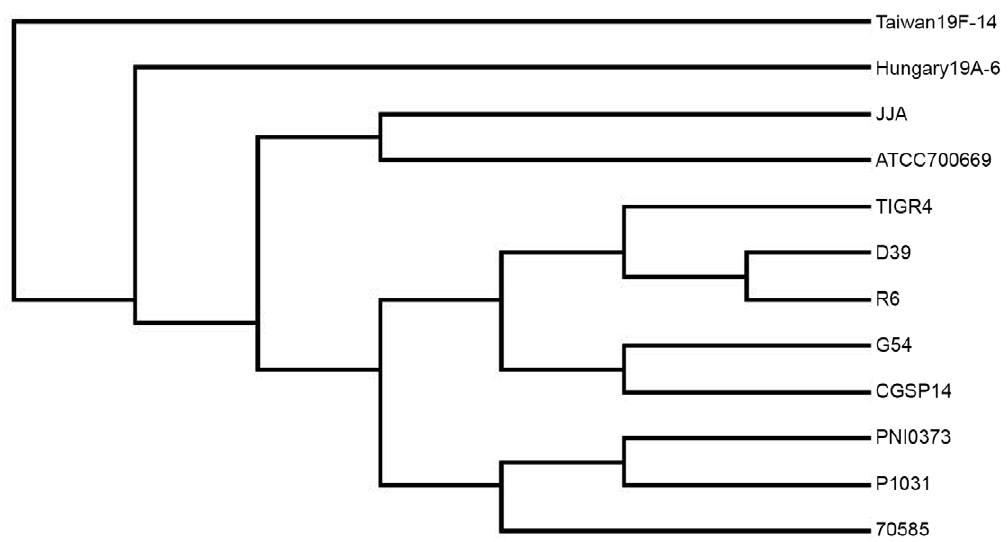
Figure 5. Gene content-based dendrogram of complete pneumococcal genomes. The presence or absence of orthologs within clusters for each genome was ascertained. After normalizing the data using the weighted average genome size from our data set, the above dendrogram was generated from our normalized gene content matrix in BioNJ. The two serotype 1 isolates, PNI0373 and P1031, clustered closely together indicating a strong relationship based on gene content. The serotype 5 genome,70585, also clustered closely with the serotype 1 genomes. Both serotype 1 and 5 pneumococci are rarely found in carriage and highly invasive. The dotted-line box highlights relationship of serotype 1 and serotype 5 genomes to each other.